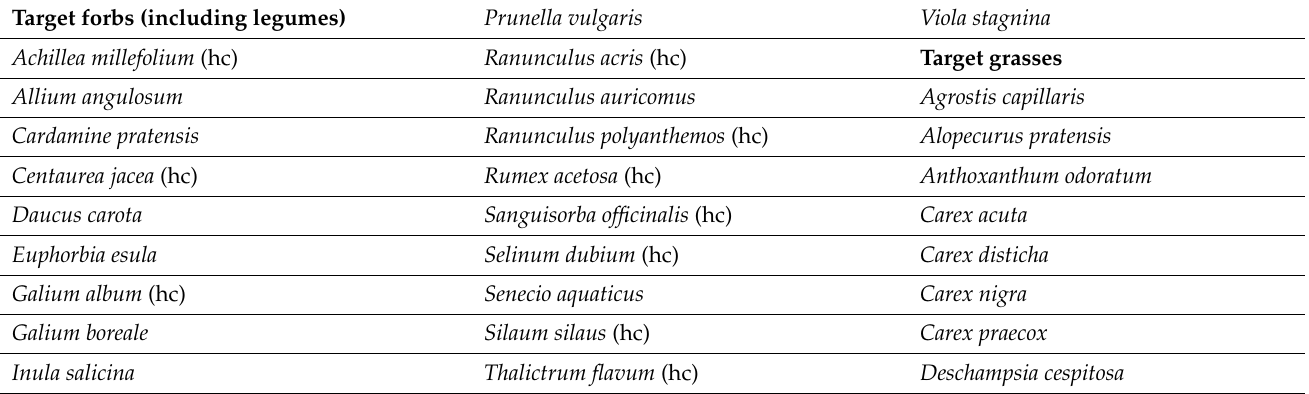
Figure A3. Development of percentage cover of the five most important grasses with different fertiliza- tion treatments between 2010 and 2018 (except 2016). Table A2. Target species (characteristic species of habitat type 6440 (LAU 2010)), characteristic species and low-growing forbs of the Sanguisorbo officinalis-Silaetum silai (Schubert [58]). High-competitive target forbs (hc) = ecological strategy types C and CS (after Grime et al. [71]), all other species belong to the group of low-competitive target